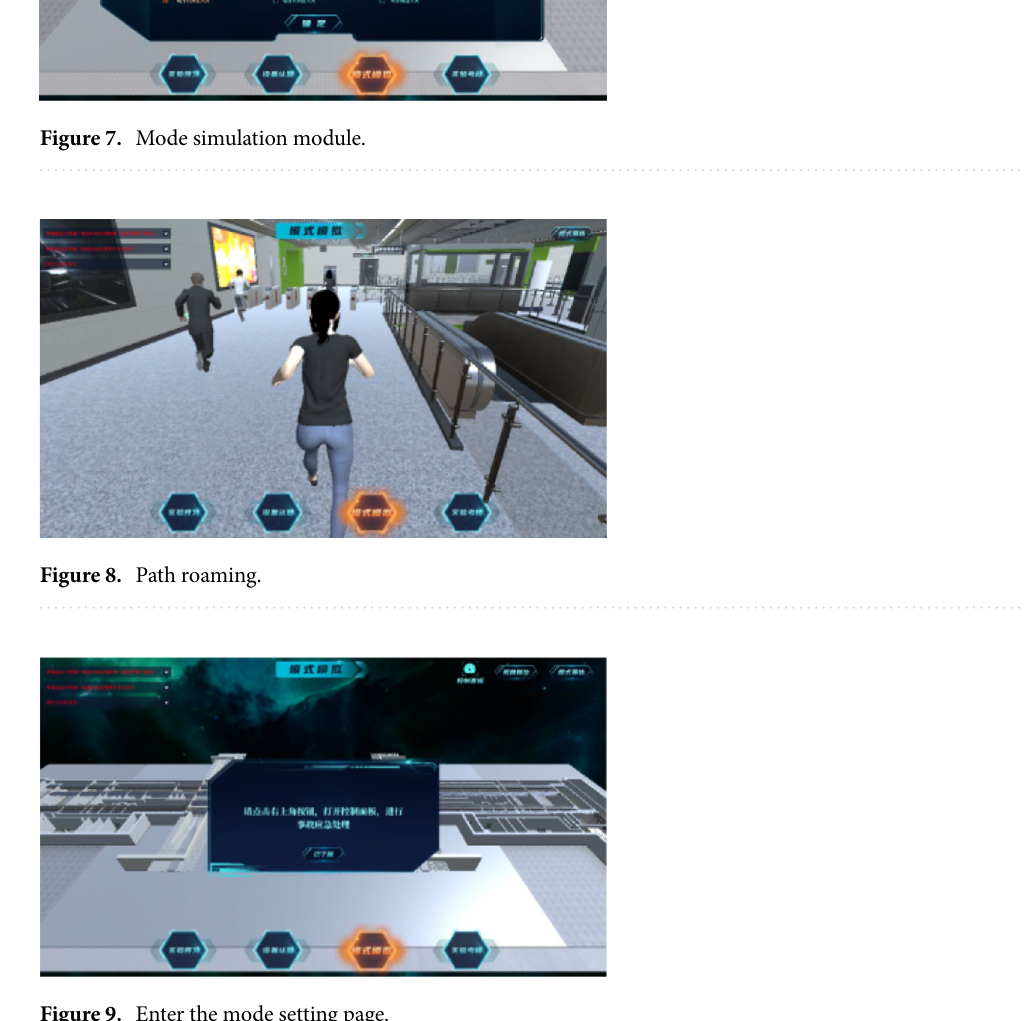
Figure 9. Enter the mode setting